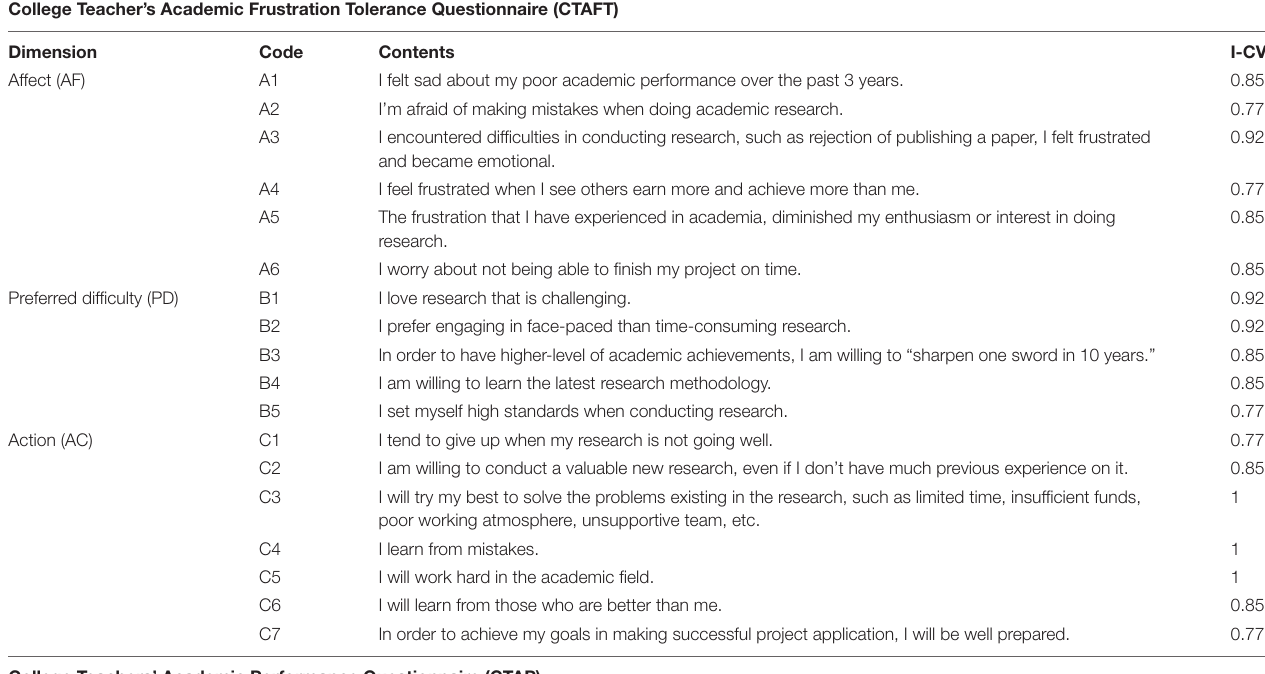
TABLE 1 | Code and contents in each dimension and the I-CVI value of CTAFT and CTAP. College Teacher’s Academic Frustration Tolerance Questionnaire (CTAFT)